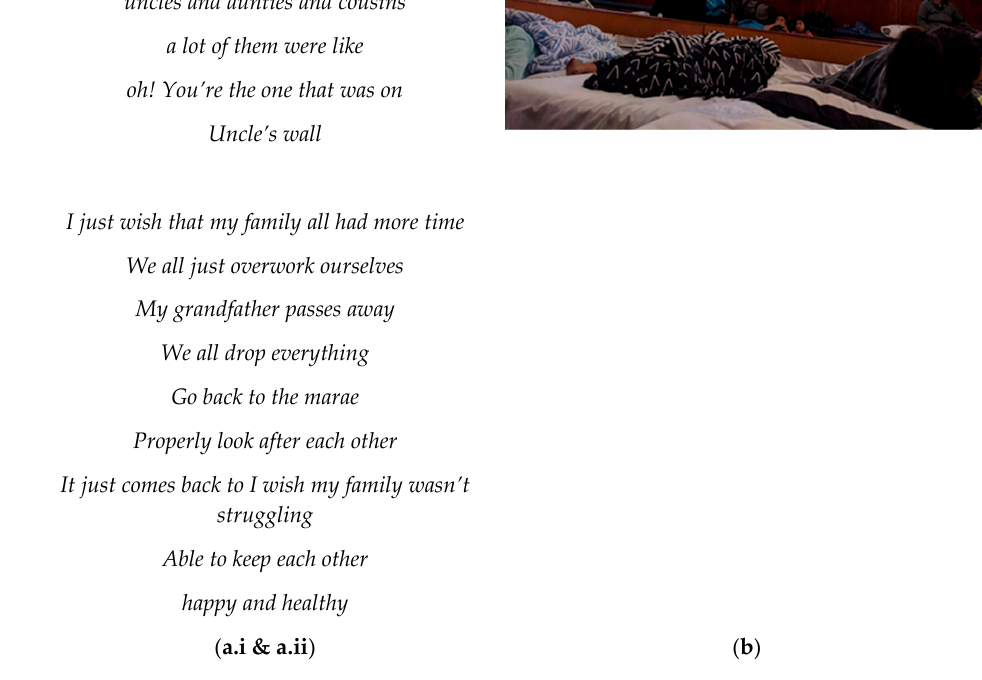
Figure 3. This figure depicts ( a.i ) Stanza 5 of the poem; ( a.ii ) Stanza 6 of the poem; ( b ) Image taken by Waimirirangi within her whare t ū puna (meeting